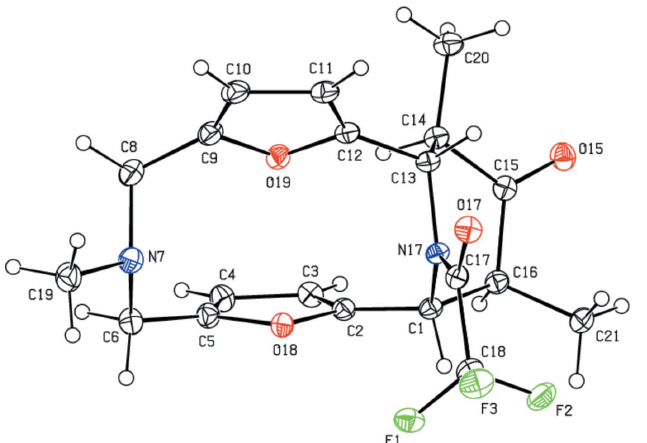
Figure 2 Molecular structure of the title compound. Displacement ellipsoids are drawn at the 30% probability level.